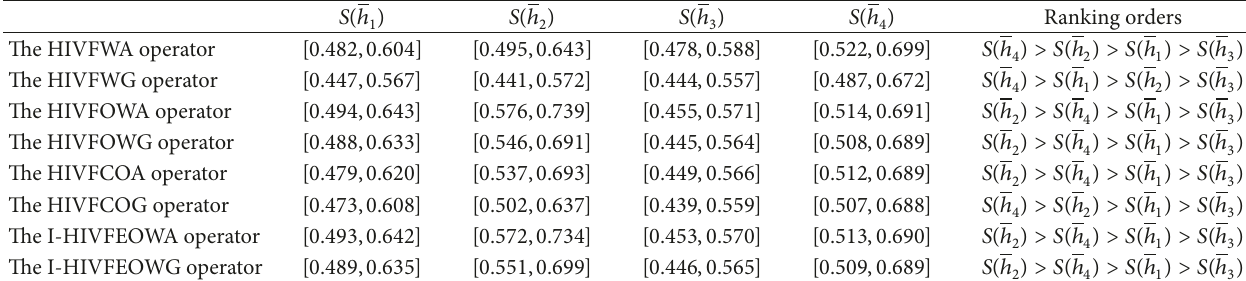
Table 12: Ranking results with respect to different aggregation